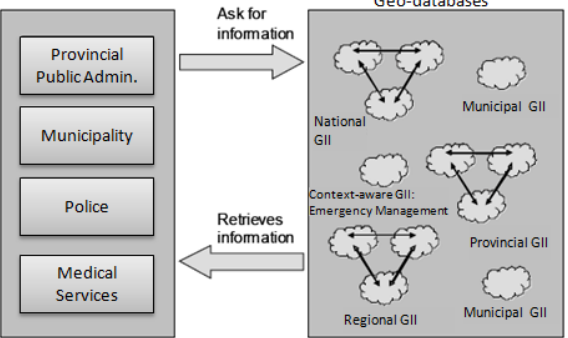
Figure 1. An Overview of context-aware GDI for disaster management (adapted from (Borkulo et al.